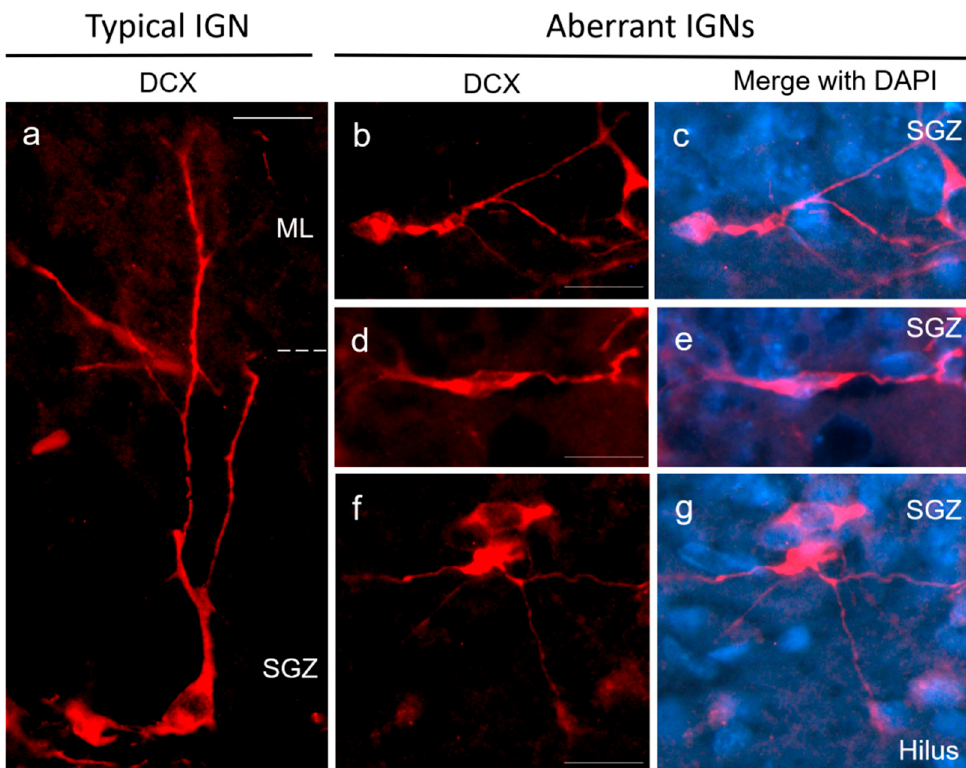
Figure 12. Morphologies of aberrant immature granular neurons (IGNs) located in the ventral dentate gyrus. ( a ) Typical morphology of IGNs in the ventral dentate gyrus (DCX: doublecortin). Their somas are on the subgranular zone (SGZ), and their dendrites are projected to the molecular layer (ML) of the dentate gyrus. ( b – g ) Aberrant IGNs with monopolar ( b , c ) or bipolar ( d , e ) dendritic processes oriented horizontally to the granule cell layer, or with dendritic processes toward the hilus ( f , g ). DCX: red, DAPI: blue, Scale bar: 20 µm.